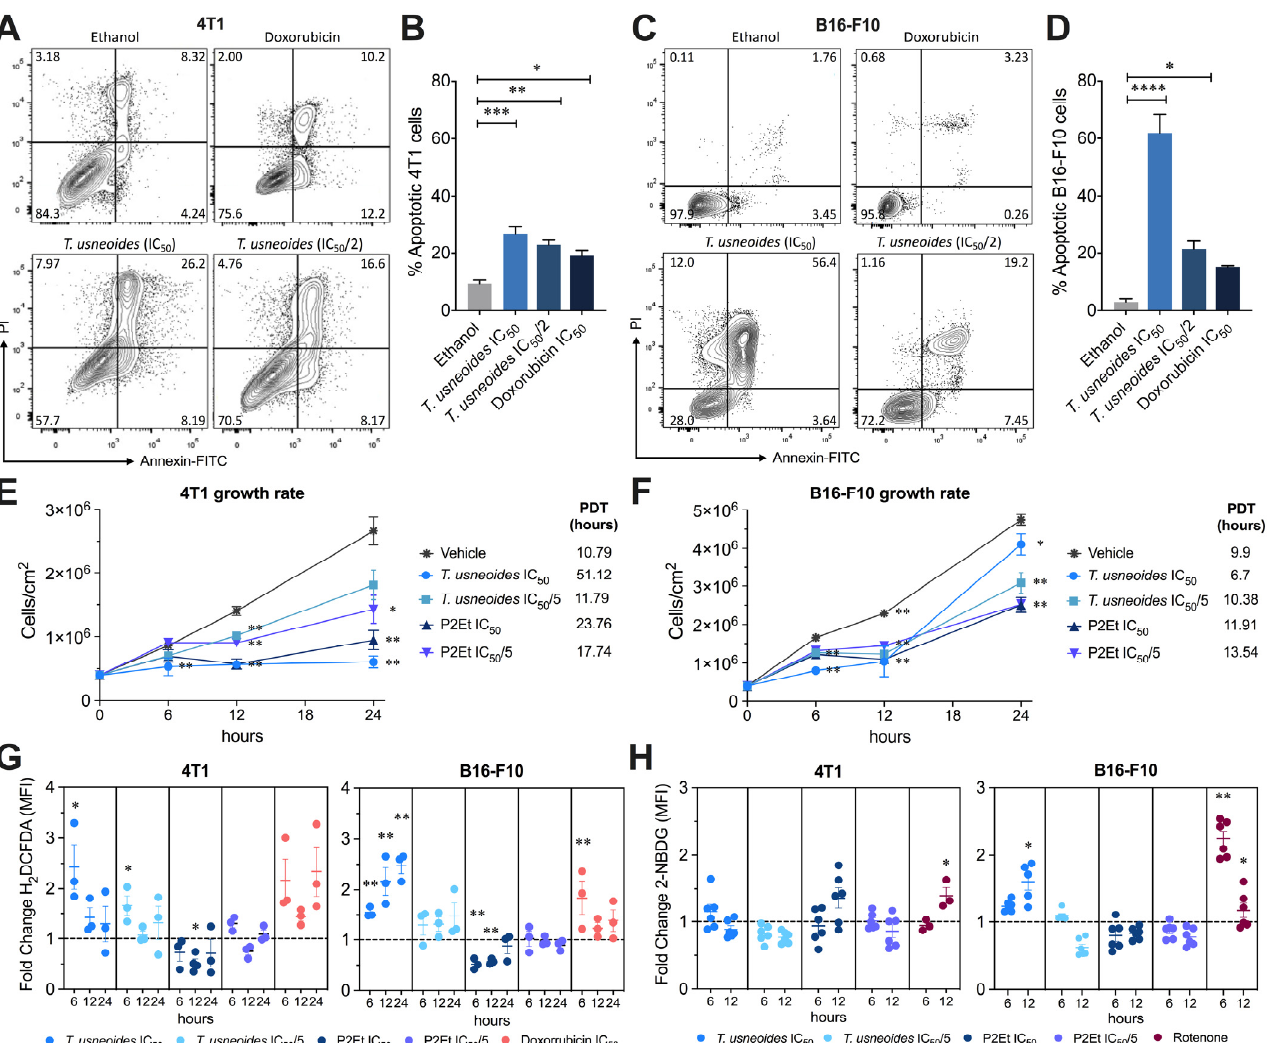
Figure 2. T. usneoides extract-induced apoptosis on 4T1 cells. ( A ). Representative contour plots of 4T1 cells incubated with IC 50 (48.95 µ g/mL) and IC 50 /2 (24.47 µ g/mL) of T. usneoides extract, negative control (ethanol), or control positive (doxorubicin) for 24h. In representative flow cytometry analysis, necrotic (Annexin V − , PI + ), late apoptotic (Annexin V + , PI + ), early apoptotic (Annexin V + , PI − ), and viable (Annexin V − , PI − ) cells were indicated. ( B ). Frequency of apoptotic 4T1 cells (sum of early and late apoptosis) expressed as mean ± SEM for three independent experiments. ( C ). Representative contour plots of B16-F10 cells incubated with IC 50 (48.35 µ g/mL) and IC 50 /2 (24.18 µ g/mL) of T. usneoides extract, negative control (ethanol), or control positive (doxorubicin) for 24 h. ( D ). Frequency of apoptotic B16-F10 cells (sum of early and late apoptosis) expressed as mean ± SEM for three independent experiments. ( E ). 4T1 and ( F ) B16-F10 cell count per cm 2 after treatment with IC 50 and IC 50 /5 of T. usneoides extract, IC 50 and IC 50 /5 of P2Et extract, or vehicle (ethanol) for 0 h, 6 h, 12 h, and 24 h. Population doubling times (PDT) are shown for each treatment. ( G ). Fold change of H 2 DCFDA MFI after the treatments with IC 50 and IC 50 /5 of T. usneoides extract, IC 50 and IC 50 /5 of P2Et extract, or doxorubicin IC 50 (positive control) for 6 h, 12 h, and 24 h in both cell lines. ( H ). Fold change of 2-NBDG MFI after treatments with IC 50 and IC 50 /5 of T. usneoides extract, IC 50 and IC 50 /5 of P2Et extract, or rotenone (positive control) for 6 h and 12 h. In all cases, fold change was determined using the MFI of each treatment relative to the vehicle (ethanol or DMSO). Data from three independent experiments are shown. * p < 0.05; ** p < 0.01; *** p < 0.001; **** p <